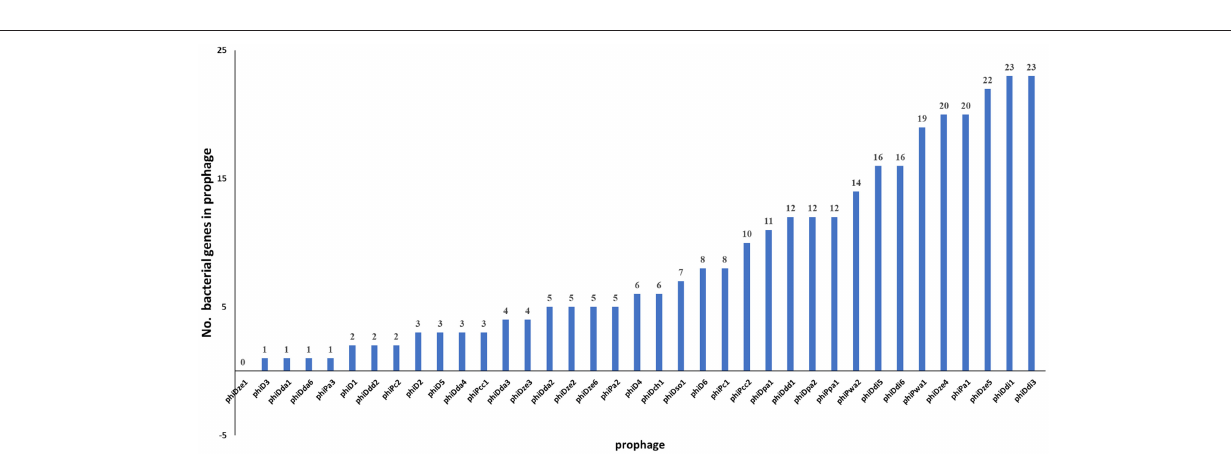
FIGURE 6 | Distribution of genes of bacterial origin in 37 seemingly intact prophages of SRP. The particular gene found in the prophage was classified as being of bacterial origin when altogether: (i) the gene is frequently present in bacterial genome(s), (ii) is unnecessary to complete bacteriophage life cycle, (iii) encodes protein with an enzymatic activity not required by the virus to interact with its